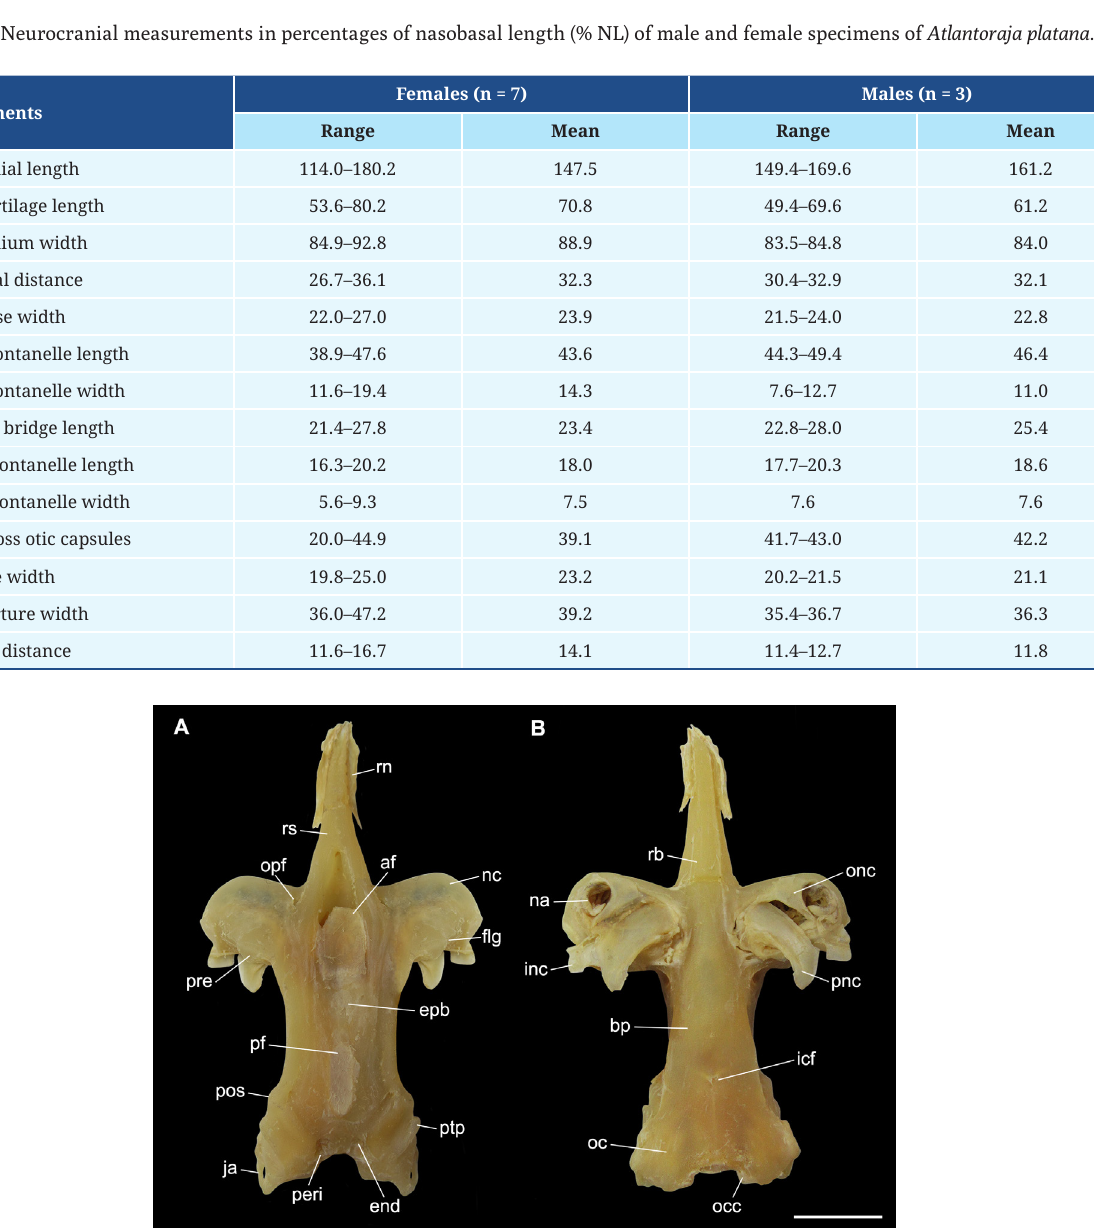
FIGURE 12 | Neurocranium of Atlantoraja platana , UERJ 1383, male, 372 mm TL. A. Dorsal view. B. Ventral view. af , anterior fontanelle; bp , basal plate; end , endolymphatic foramen; epb , epiphysial bridge; flg , flange; icf , internal carotid artery foramen; inc , inner nasal cartilage ja , jugal arch; na , nasal aperture; nc , nasal capsule; oc , otic capsule; occ , occipital condyle; onc , outer nasal cartilage; opf , ophthalmic